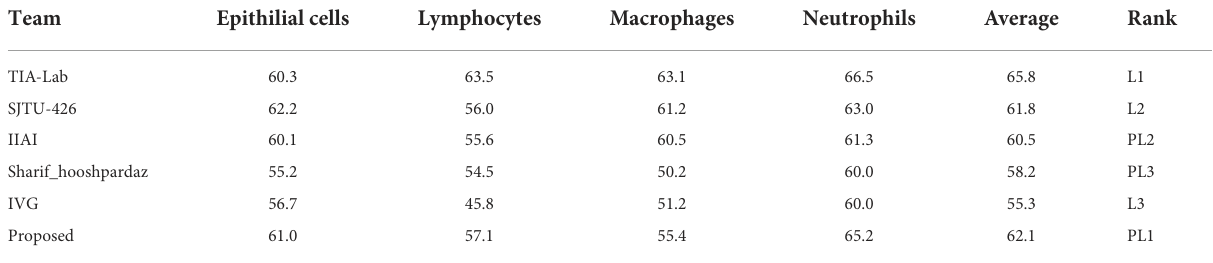
TABLE 4 Nuclei instance segmentation and classification results on the MoNuSAC challenge test data in terms of average PQ scores for different nucleus classes.